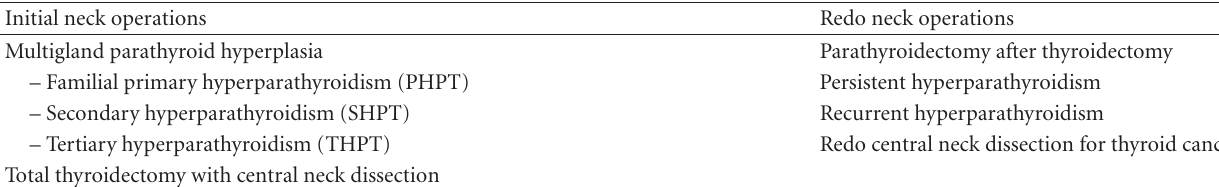
Table 1: Indications for parathyroid